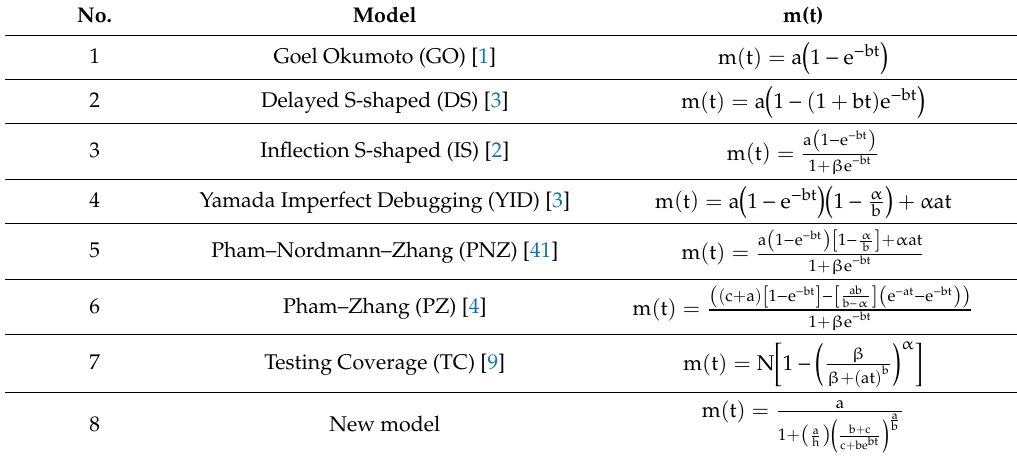
Table 1. Mean value functions of software reliability growth models